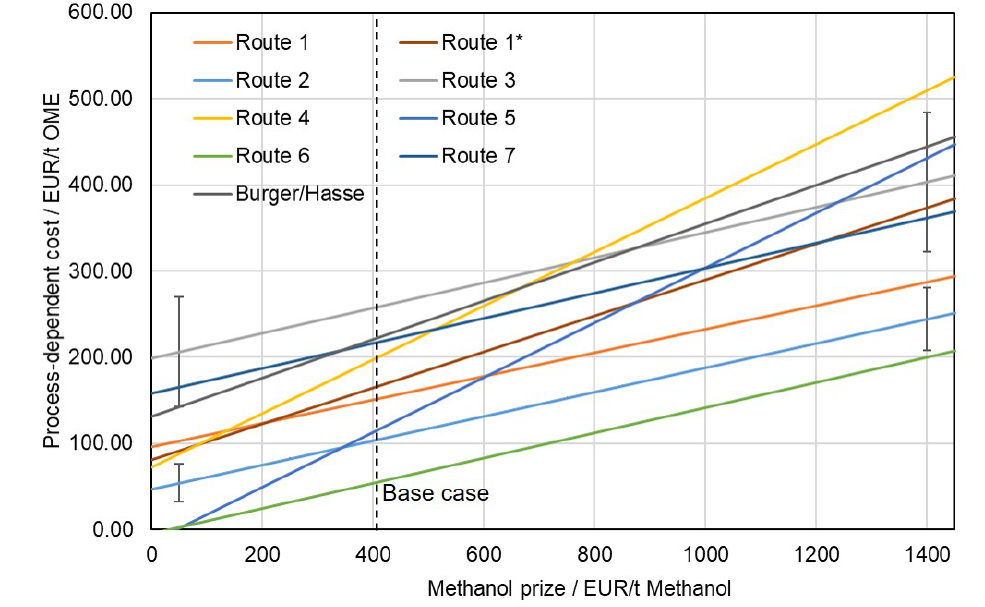
Figure 6. Process-dependent cost per t OME for all routes as a function of the methanol cost for a plant size of 100